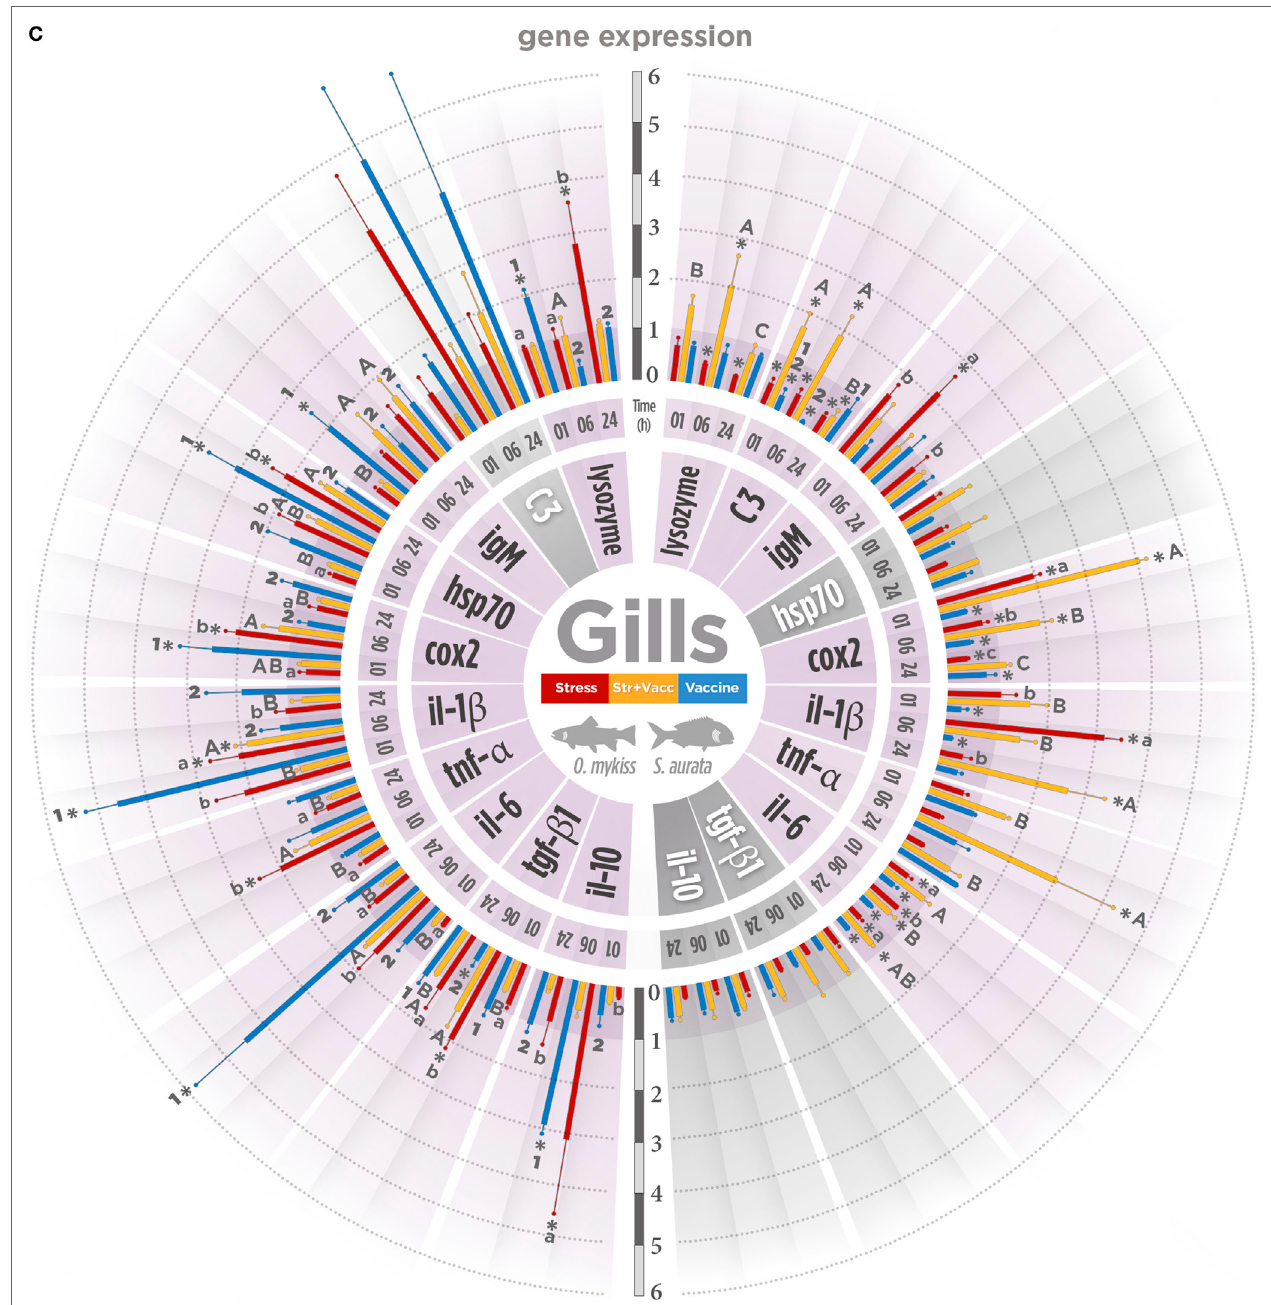
FigUre 3 | Gene expression level in gill-associated lymphoid tissue (GIALT) after a biotic ( Vibrio anguillarum bacterin), abiotic (air exposure), or the combination of both stressors (vaccine + air exposure) at 1, 6, and 24 h post-stress. Quantitative real-time PCR quantification of specific mRNA immune and stress transcripts ( lysozyme , c3, igm, hsp70, cox2, Il1 β , tnf α , il6, tgf β 1 , and il10 ) in (a) rainbow trout and (B) gilthead seabream gills. (c) Integrative comparison of GIALT transcriptomic responses. β -Actin and 18s were chosen as housekeeping genes in rainbow trout and gilthead seabream, respectively. Different colors indicate different treatments: red (air exposure), orange (vaccine + air exposure), blue (vaccine), and gray (ctrl; control). Time zero represents the end of the acute air exposure stress (for the air exposure and the vaccine + air exposure) or 24 h after bath vaccination (for vaccine group). Data are represented as mean ± SE ( n = 8 per sampling time point). Significant differences are indicated by lower case in the air exposure group, by upper case in the vaccine + air exposure group, and by numbers in the vaccine group. Asterisk (*) indicates significant difference of each treatment versus control ( p <